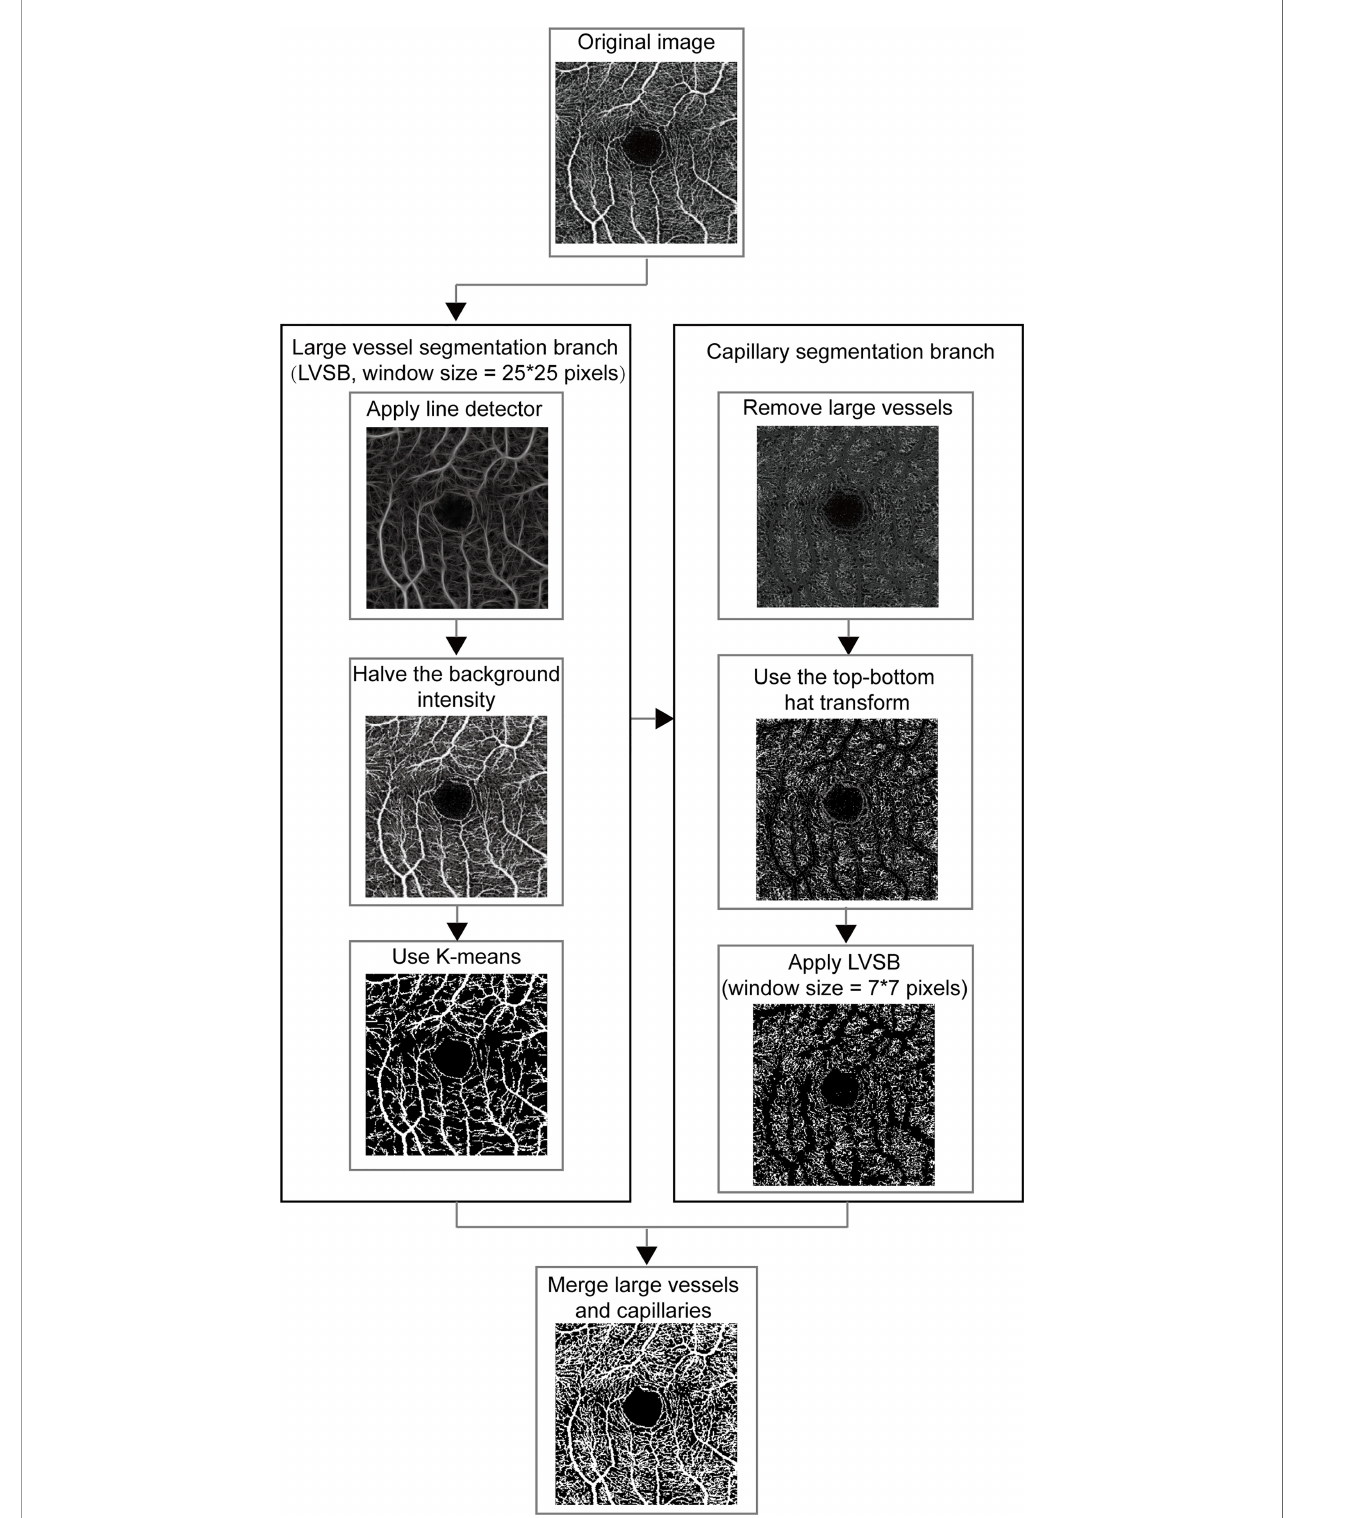
FIGURE 1 | The framework for vessel segmentation method on OCTA image. LVSB, large vessel segmentation branch.